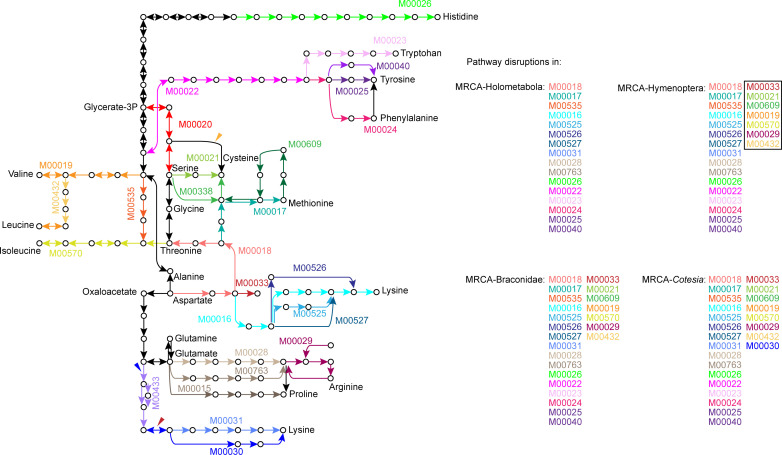
Amino acid biosynthetic pathways that have been disrupted in the most recent common ancestor (MRCA) of Holometabola, MRCA of Hymenoptera, MRCA of Braconidae and MRCA of Cotesia.We defined a pathway disruption as the loss of one or more genes required for amino acid synthesis in the pathway (KEGG modules). The KEGG modules in black box mean the novel disruptions compared to the outgroups. The amino acid biosynthetic pathways are redrawn from KEGG pathway, map01230. The gene losses caused the pathway disruptions during the Hymenoptera evolution are shown in colorful arrows, corresponding to the pathway disruption events shown in Figure 2A.